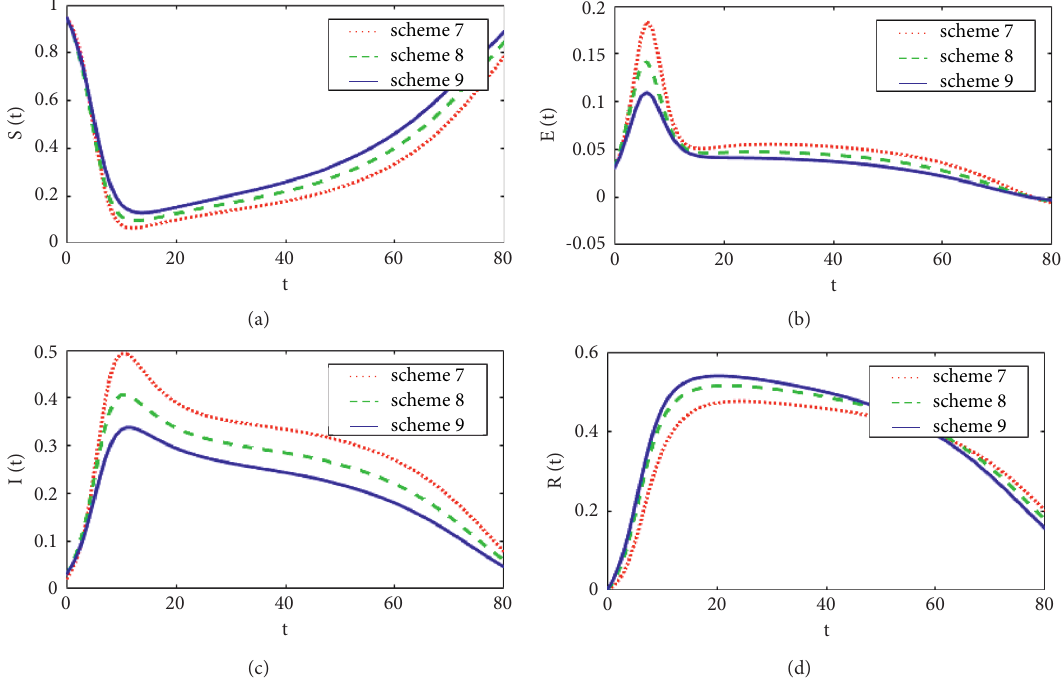
Figure 4: Curves of changes in the population density of the four categories of netizens at different values of μ